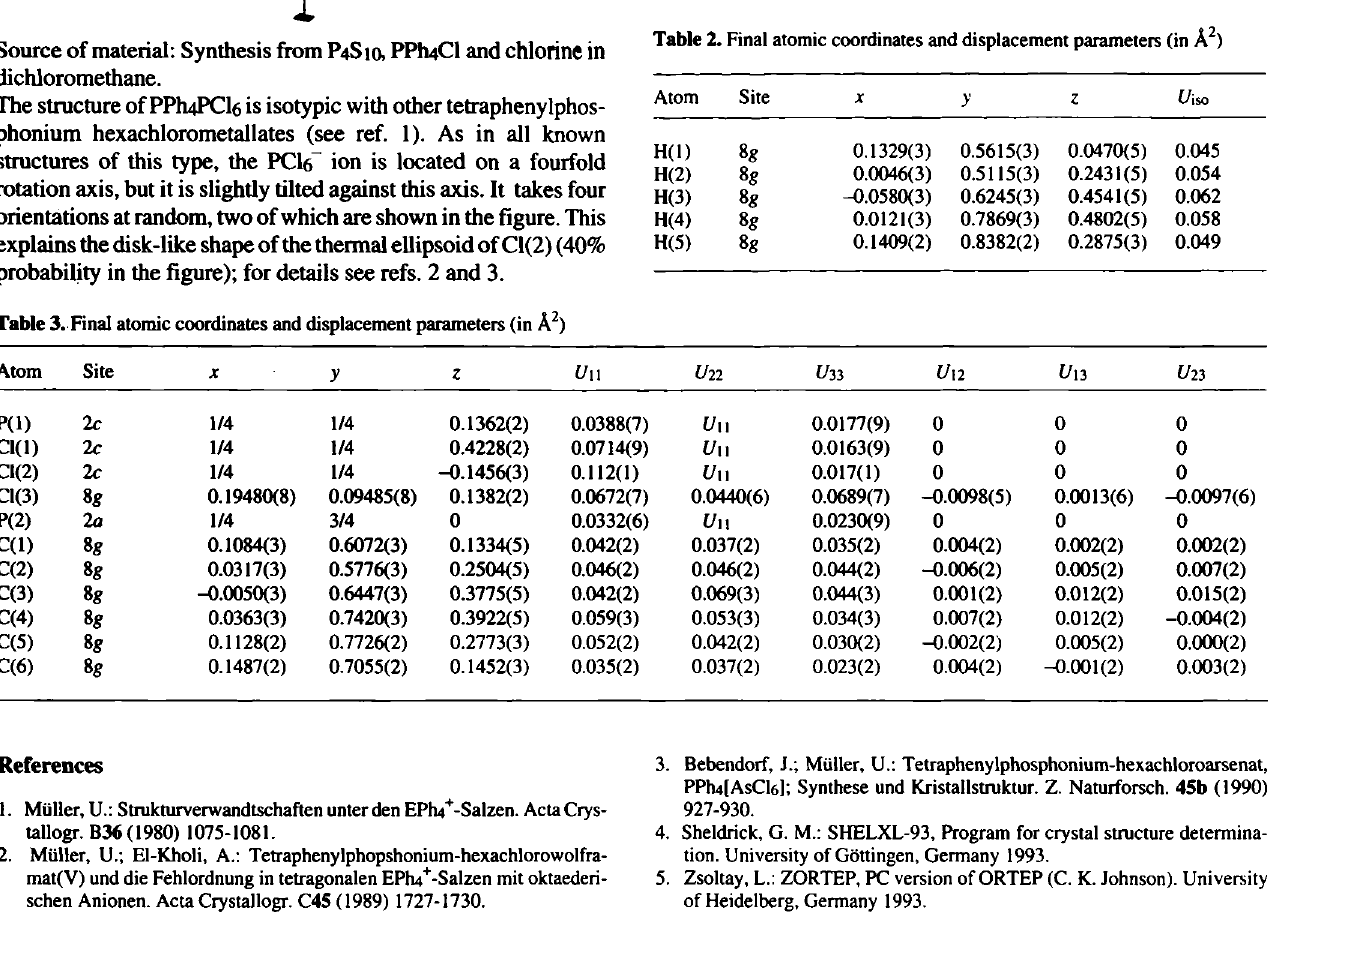
Table 2. Final atomic coordinates and displacement parameters (in